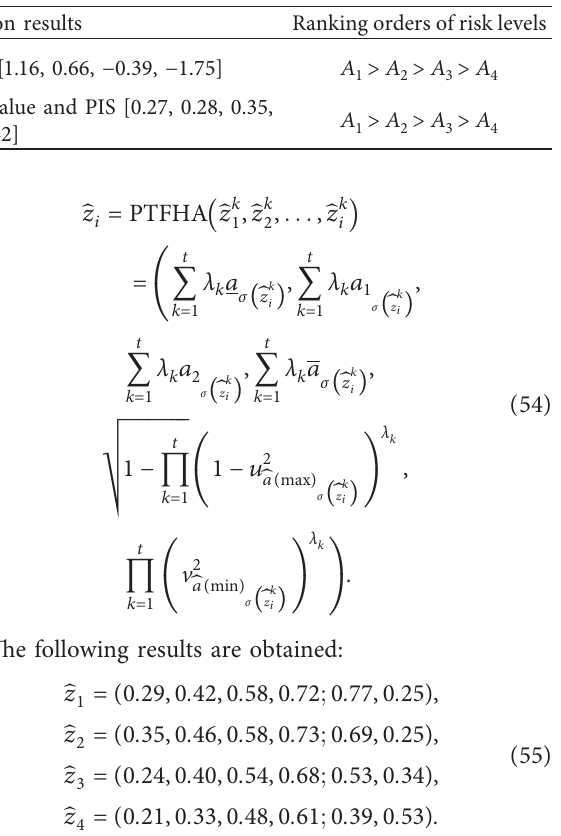
Table 9: The comparison analysis results with different methods.